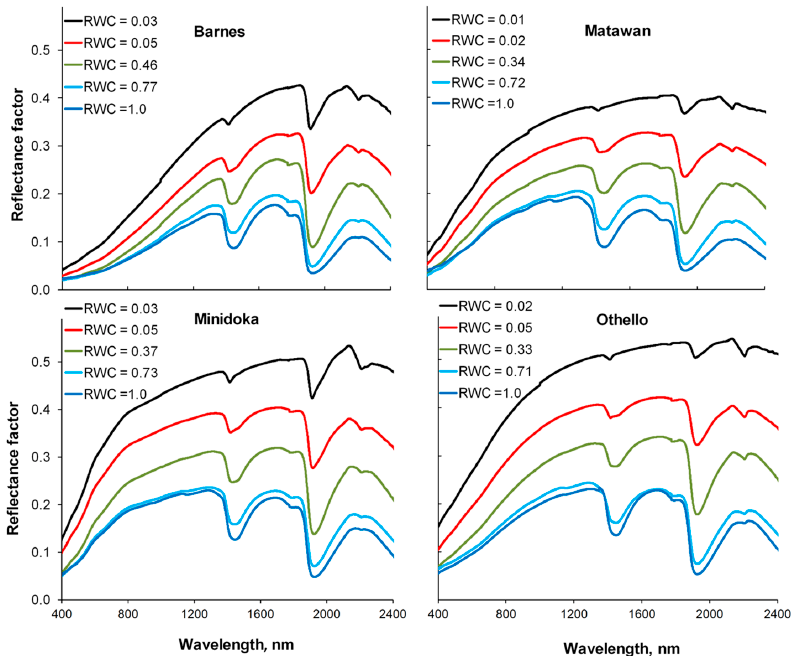
Figure 3. Reflectance spectra of four soils at various relative water contents (RWC) collected in the laboratory.